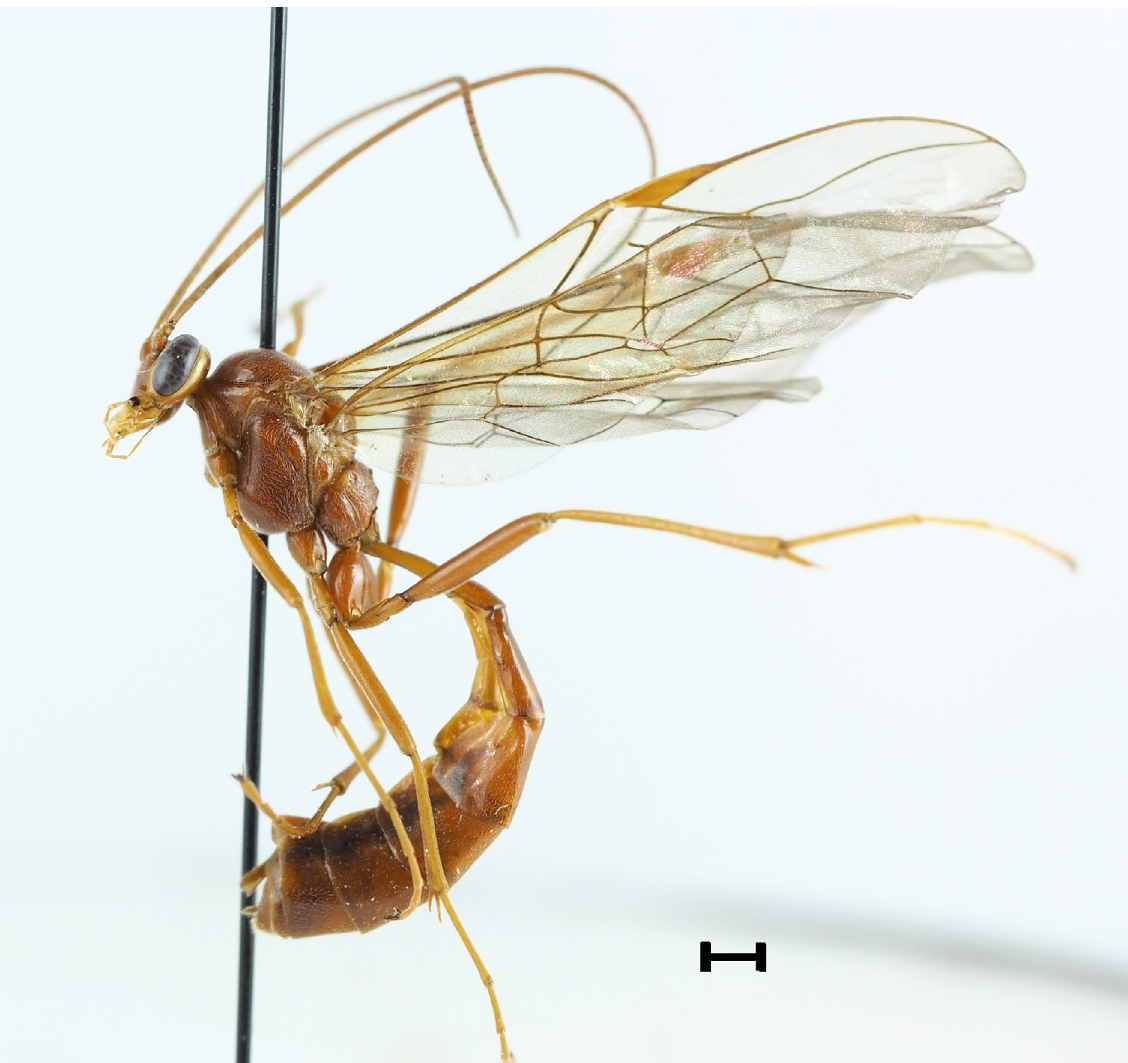
Fig. 27. Ophion broadi Johansson sp. nov., holotype, ♀ (NHRS-HEVA000008946). Scale bar = 1